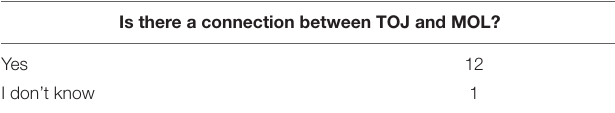
TABLE 5 | Frequencies of coded category “Connection between TOJ and MOL”.